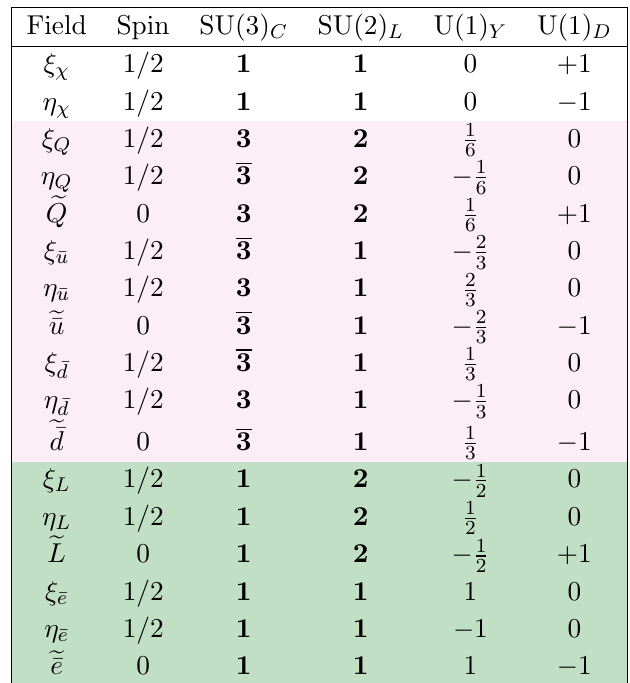
Table 1 . Quantum numbers of DM and mediators. A new global symmetry U(1) of the